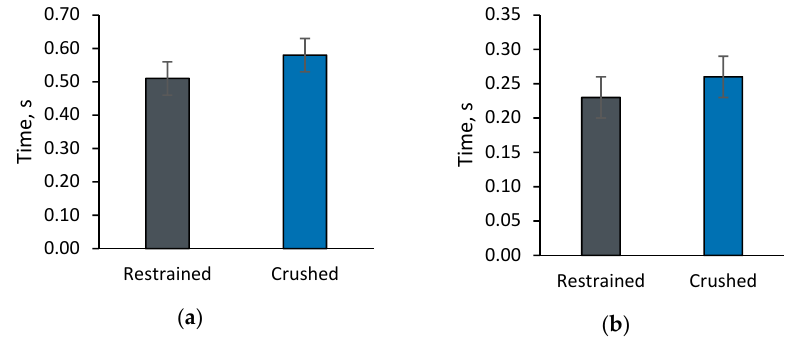
Figure 2. Time parameters of calls produced by piglets during manual restraint by a human handler ( n = 10; 659 calls total) or during a crushing event by a sow ( n = 10; 631 calls total) in the first 48 h of life. ( a ) Total duration of each call produced; ( b ) Start to peak within each call.